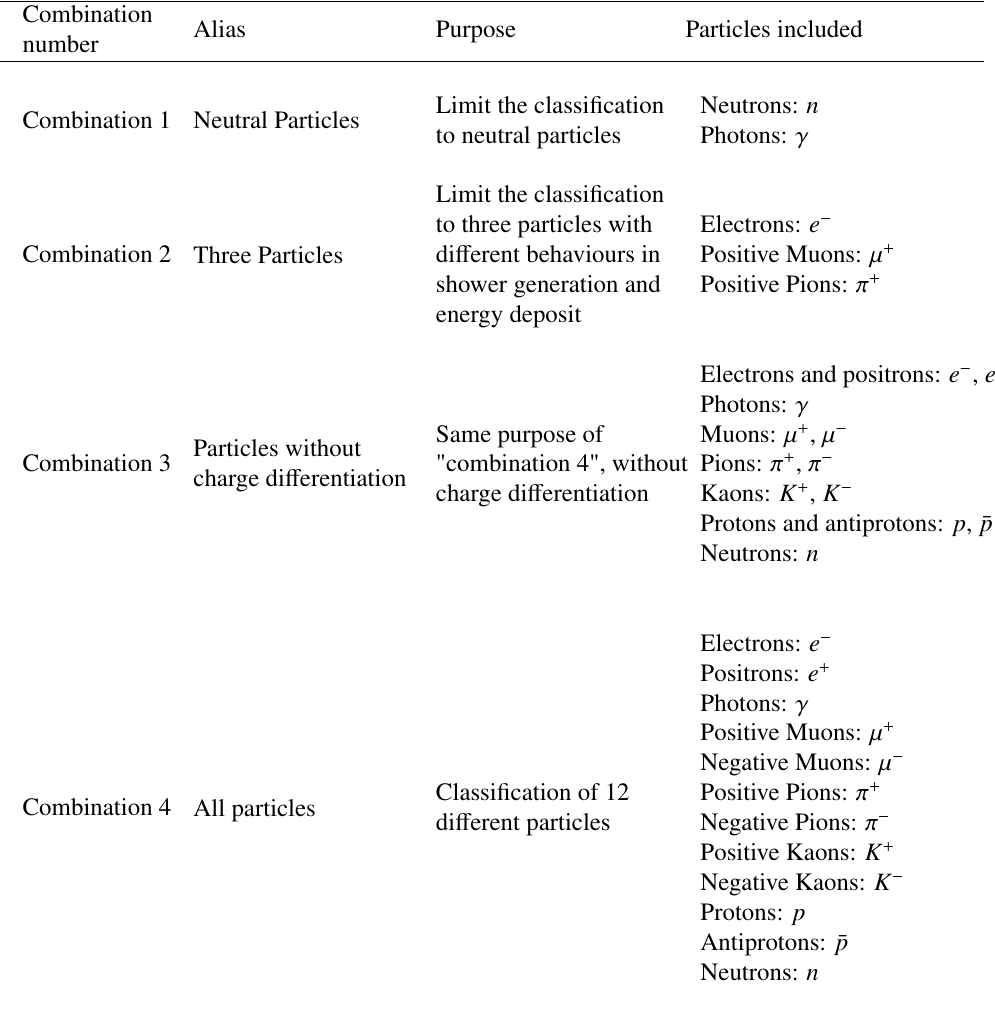
Table 1. Balanced combinations of